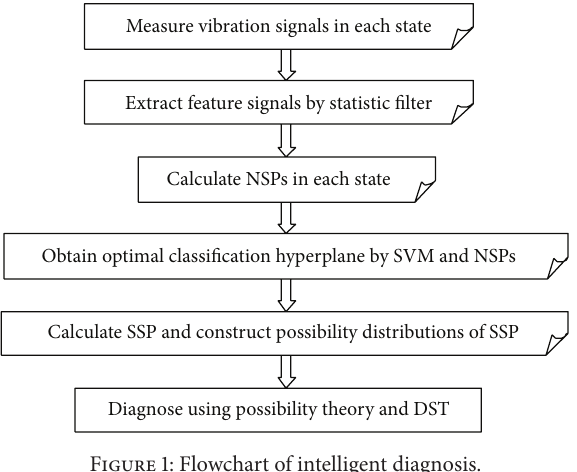
Figure 1: Flowchart of intelligent diagnosis.